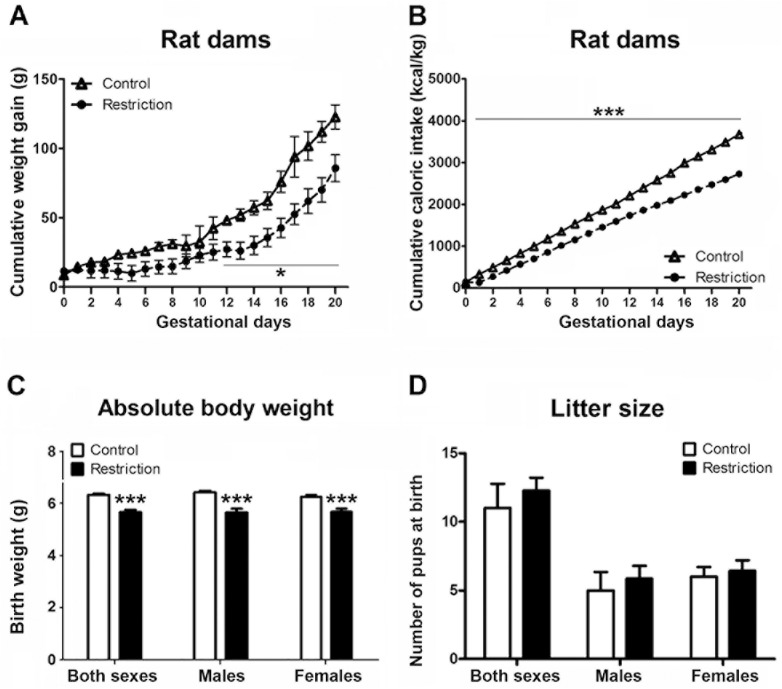
Effect of gestational calorie-restriction on rat dams and birth outcomes.Experiments started the following day of mating. Calorie-restricted rat dams (n = 7) received 80% of control dams (n = 4) food intake according to body weight, which was measured daily (restriction of 20%). Calorie-restricted diet lasted until birth. Figures A and B describe the cumulative weight gain (g) and cumulative caloric intake (Kcal/Kg), respectively, of control (open triangles) and calorie-restricted (solid circles) dams during pregnancy. At PN0 (birth day), litter size was evaluated and pups were sexed and weighed. Figures C and D describe the absolute body weight (g) and litter size, respectively, of offspring from control dams (n = 30) and offspring from calorie-restricted dams (n = 47) at birth (open and solid bars, respectively). Values are expressed as mean +/- SEM. Data were analyzed with repeated measures ANOVA followed by Bonferroni multiple comparisons (A, B), and Student´t test (C, D): *p<0.05, ***p<0.001.